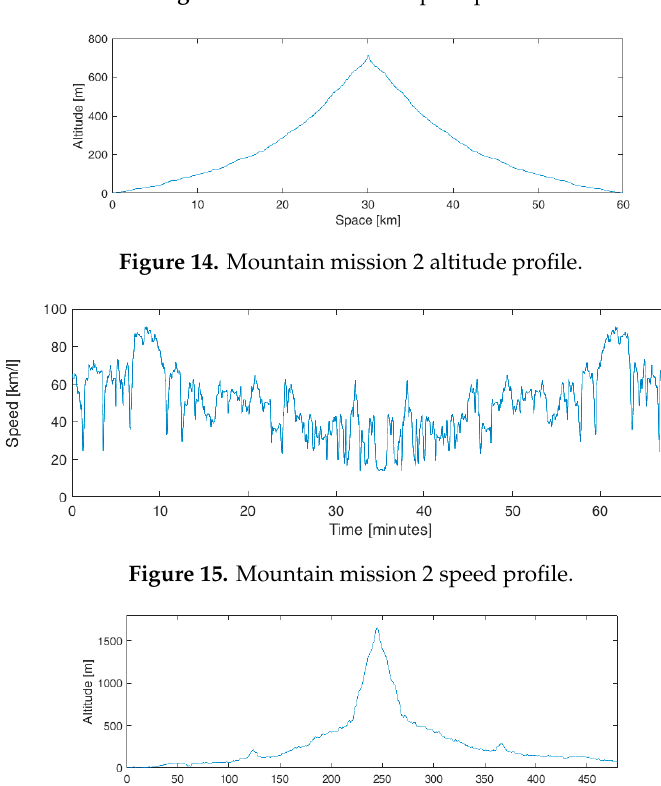
Figure 13. Extra-Urban 2 speed profile.